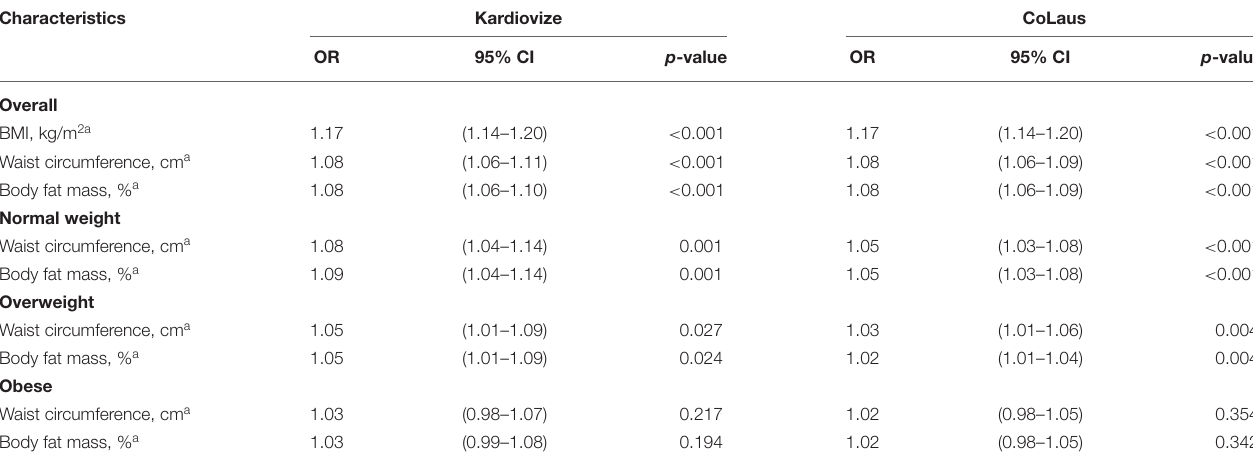
TABLE 2 | Association of anthropometric measures with metabolically unhealthy status.